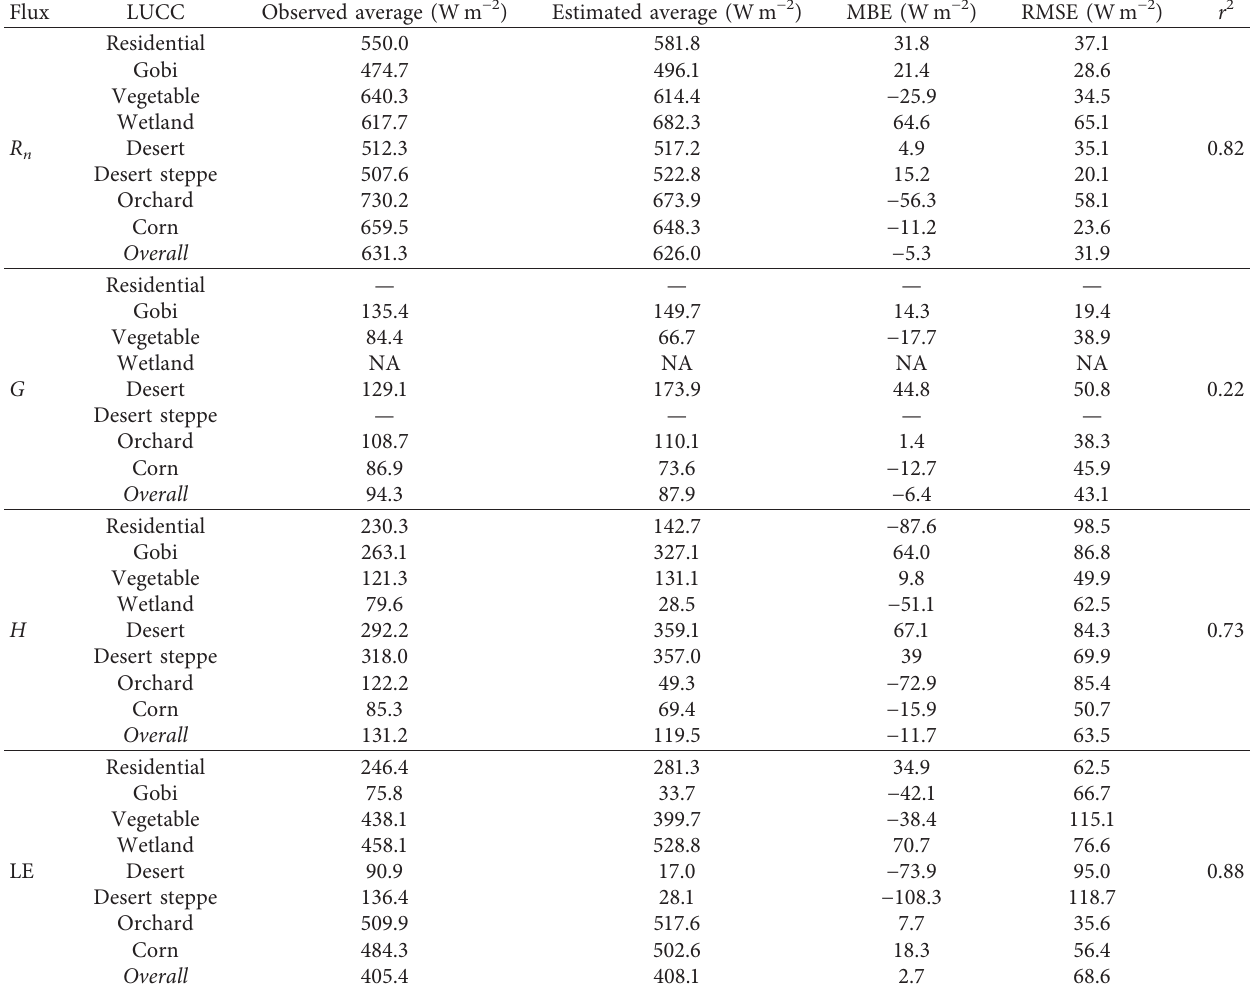
Table 1: Statistics of energy balance components ( R n , G , H , and LE) modeling accuracies by WiTSEB using ASTER images from eight dates at the HiWATER-MUSOEXE12 at the 21